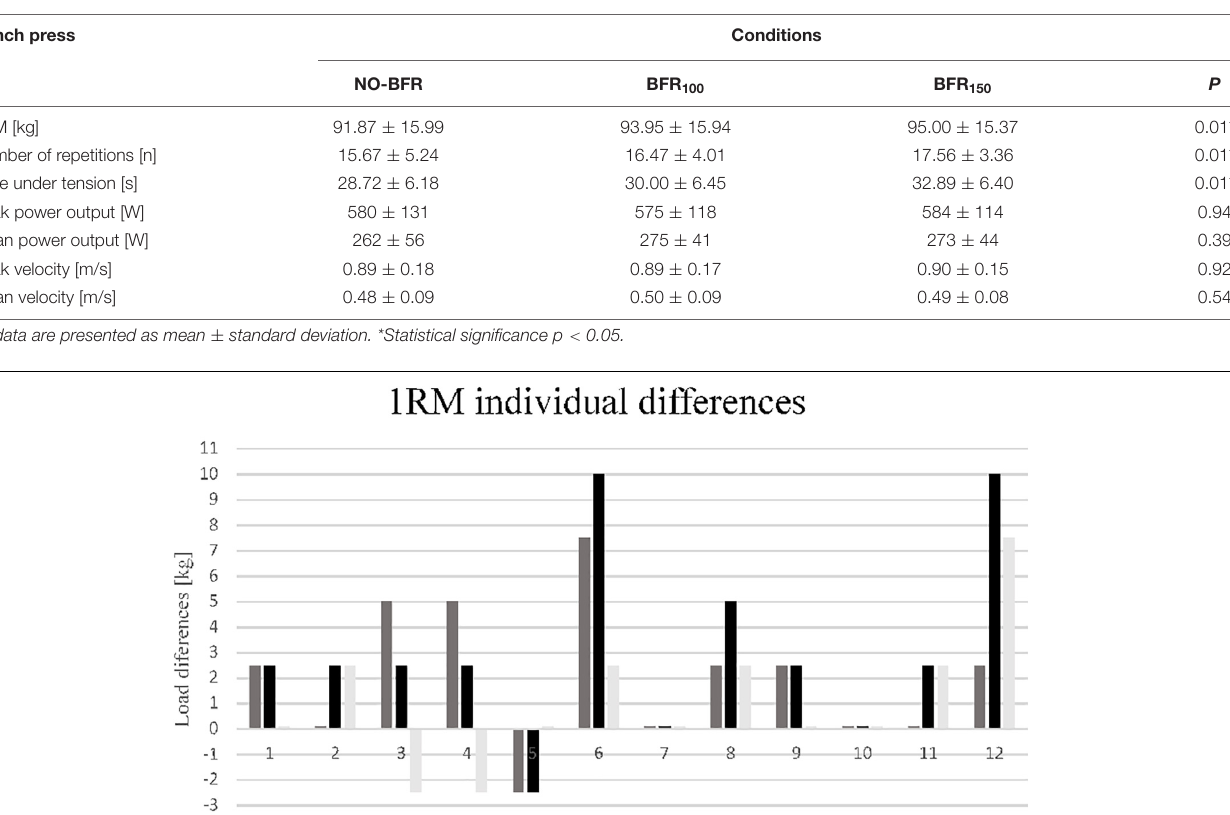
( Table 1 ). The one-way repeated measures ANOVA indicated significant condition interaction in 1RM test results ( p < 0.01;